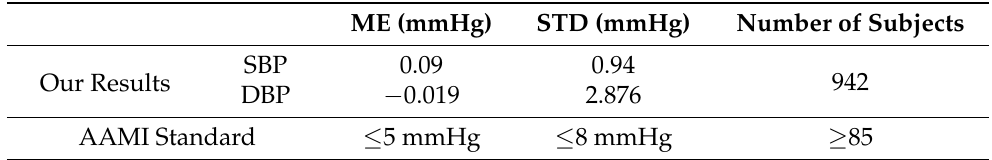
Table 10. Evaluation of BP prediction in Experiment 1 in terms of Association for the Advancement of Medical Instrumentation (AAMI)